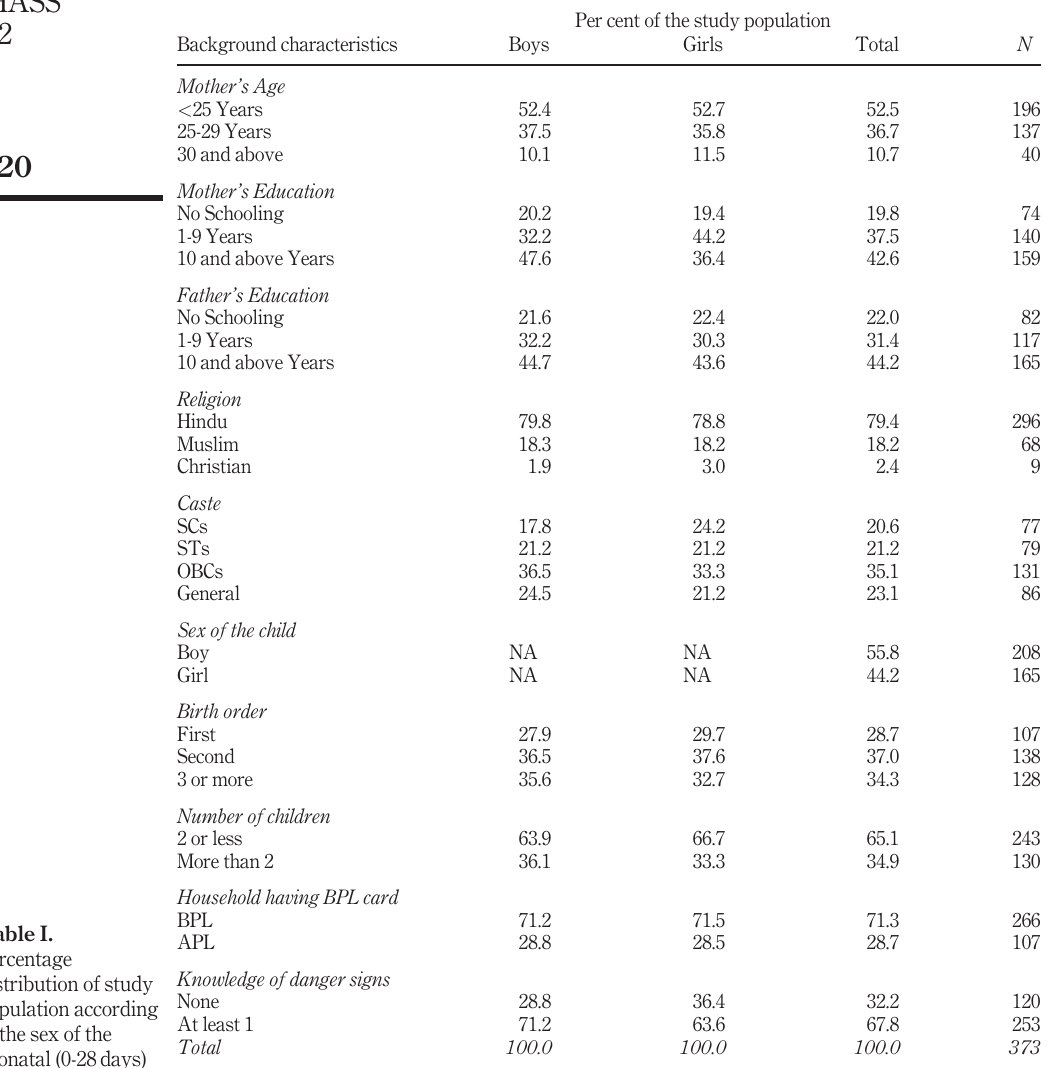
Di ff erentials in neonatal morbidity Prevalence (per 100) of reported neonatal (0-28) morbidity in the study population according to background characteristics is presented in Table II. Information on danger signs that mothers have real experience in their recently delivered newborns was collected in the